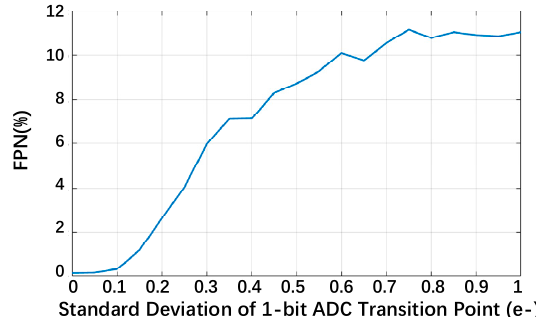
Figure 10. The fixed-pattern noise (FPN) of reconstructed images with m = 64 and z =